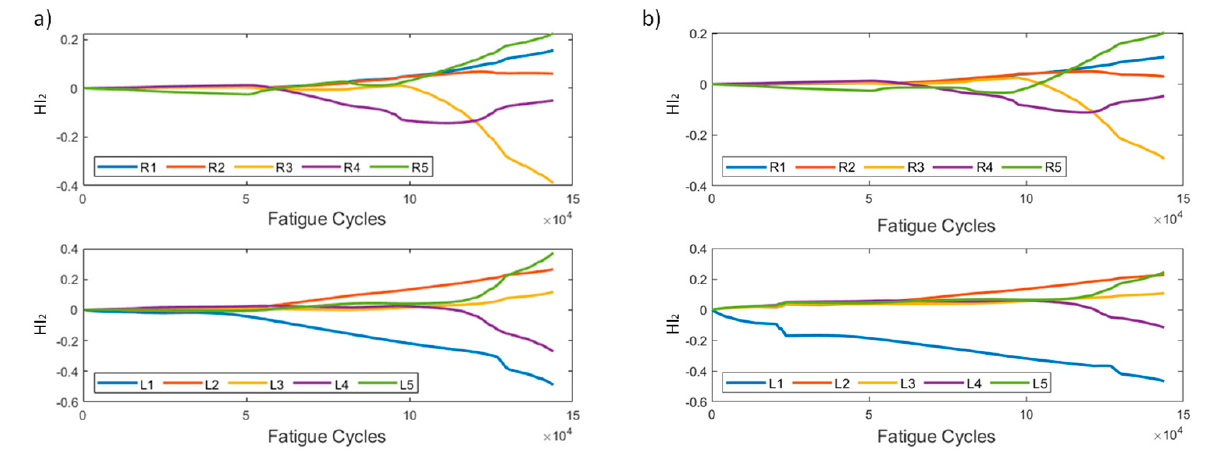
Figure 6. HI 2 progression through time for the two pre-processing methods for specimen CA-2: ( a ) method 1, ( b ) method 2.